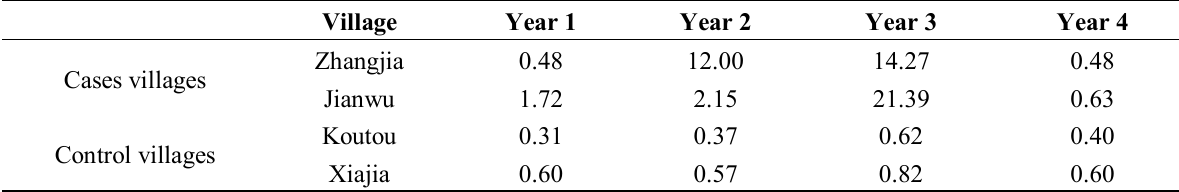
Table 5. The total unit cost of the experimental villages and control villages (Unit: US$ Ten thousand).